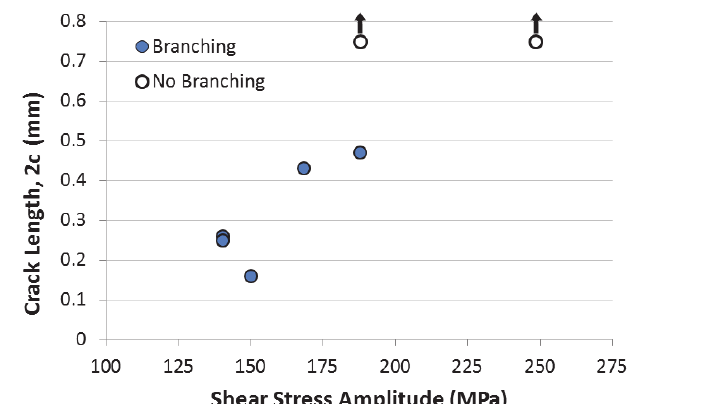
Figure 3: Initial mode II crack length before mode I branching vs. shear stress amplitude for fully-reversed pure torsion tests. Vertical arrows indicate a non-branching condition.